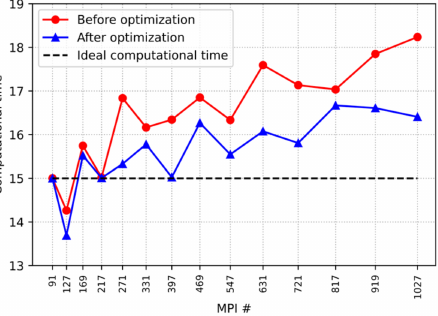
Figure 9. Computational time before and after optimization on Platform 1 (96 cores per